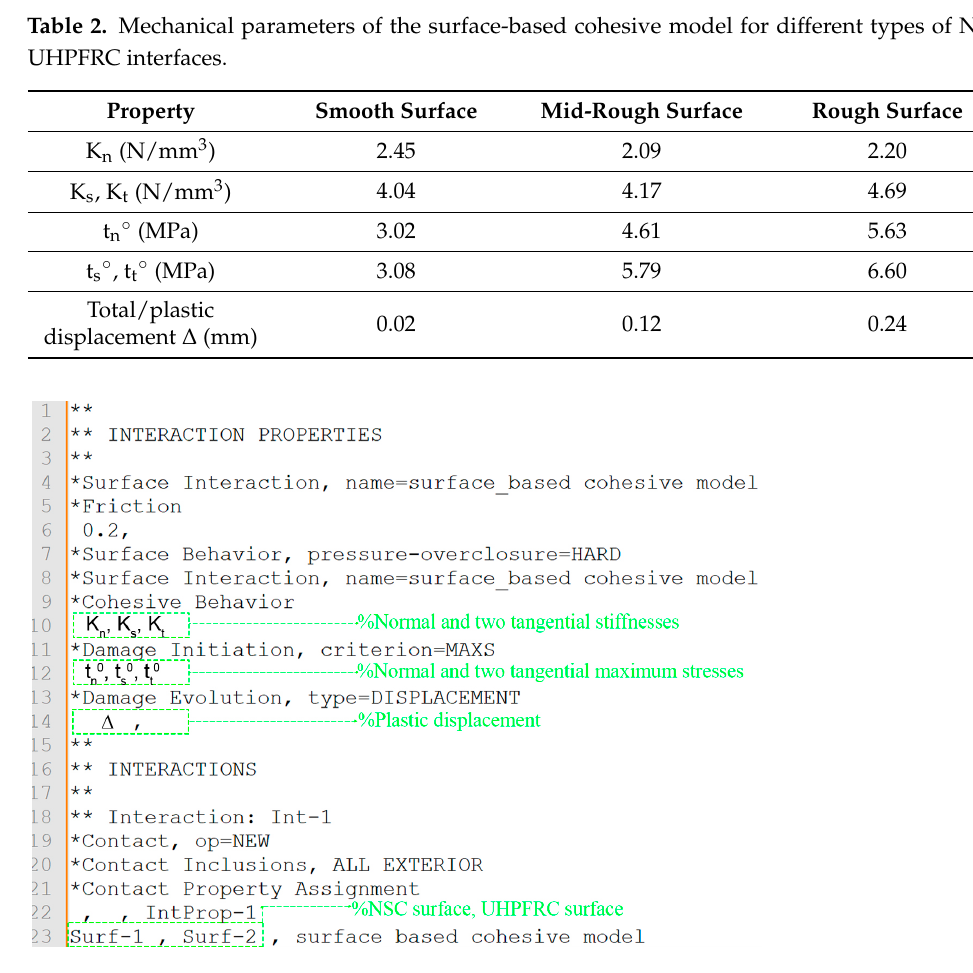
Figure 5. Input data for a surface ‐ based cohesive model on various surface types. Note: The symbols